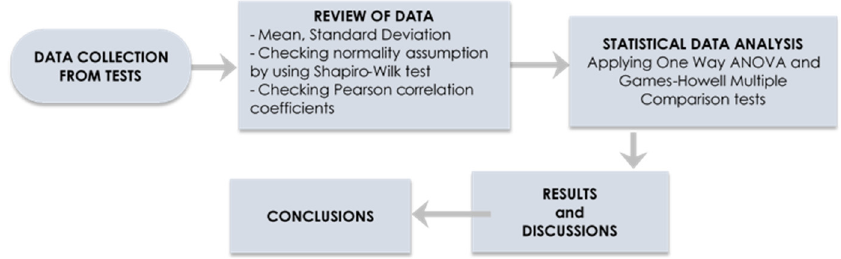
Figure 1. Methodology flow chart.